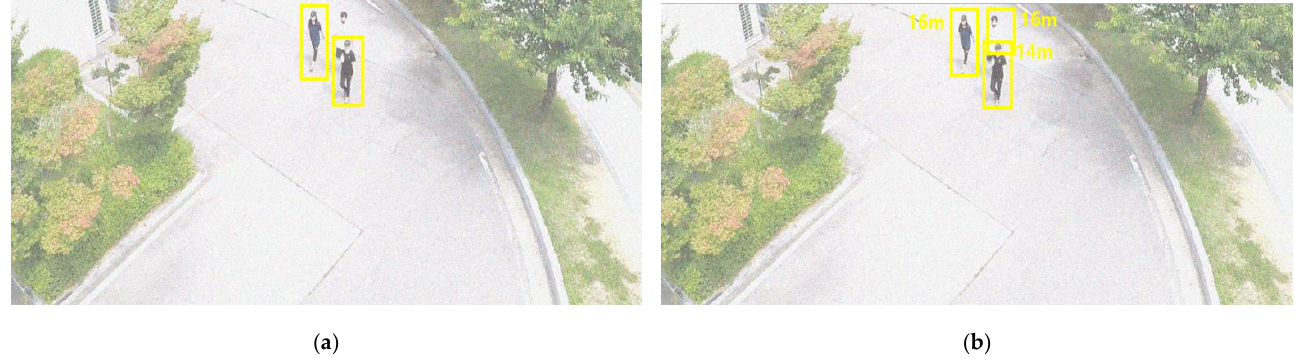
Figure 10. Comparison of pedestrian detection results by vision-based faster R-CNN ( a ) and RGDiNet ( b ).